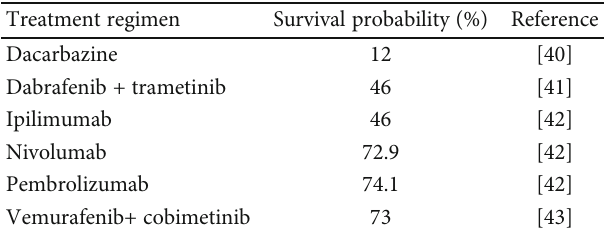
Table 1: Comparison of survival probability with various regimens for advanced melanoma after 12 months of